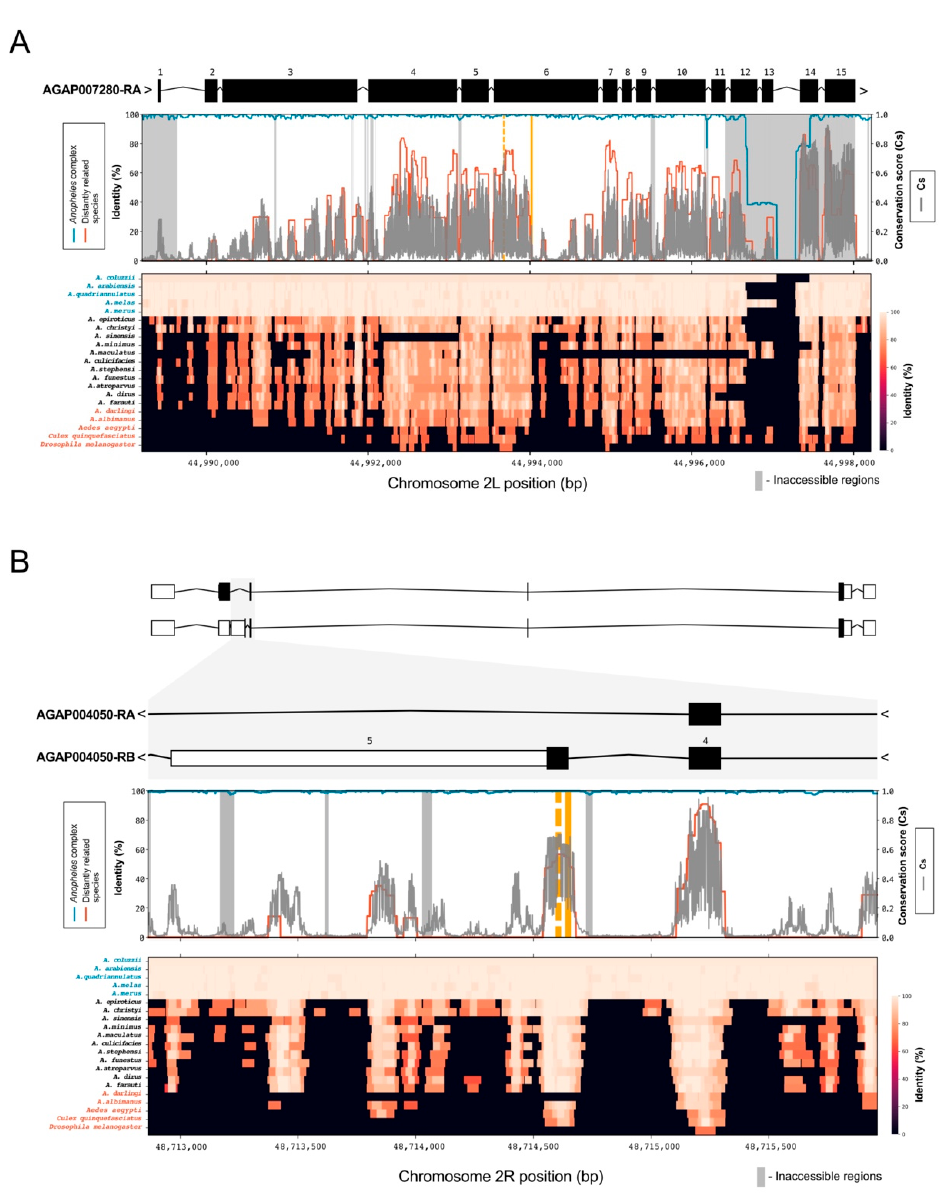
Figure 2. Conservation at AGAP007280 and AGAP004050 ( dsx ) gene drive target sites. ( A ) Top panel: the gene drive target site [9] in exon 6 of AGAP007280 gene is highlighted (solid orange line). Middle panel: average identity (in percentage) was calculated for the five genome species within the Anopheles gambiae complex (blue line) and the genomes of the five most distantly related species included in the analysis (red line). Conservation score (Cs) in gray was also calculated, considering all 21 analyzed species and An. gambiae variation. The gray blocks are masked regions considered as inaccessible [22,23] due to the low confidence of genotyping. Bottom panel: heatmap represents the identity (in percentage) for each analyzed species. Species from the An. gambiae complex are highlighted in blue, mosquito species most distantly related from An. gambiae are highlighted in red. ( B ) Target site for AGAP004050 ( dsx ) falls between intron 4 and exon 5 [11] and it is marked in orange. With the exception of two species ( An. darlingi and D. melanogaster ), the target site shows high conservation (>70%) for the Anopheles gambiae complex and more distantly related species. The alternative target sites, identified in this study, are marked with a dashed orange line and show a higher conservation score.